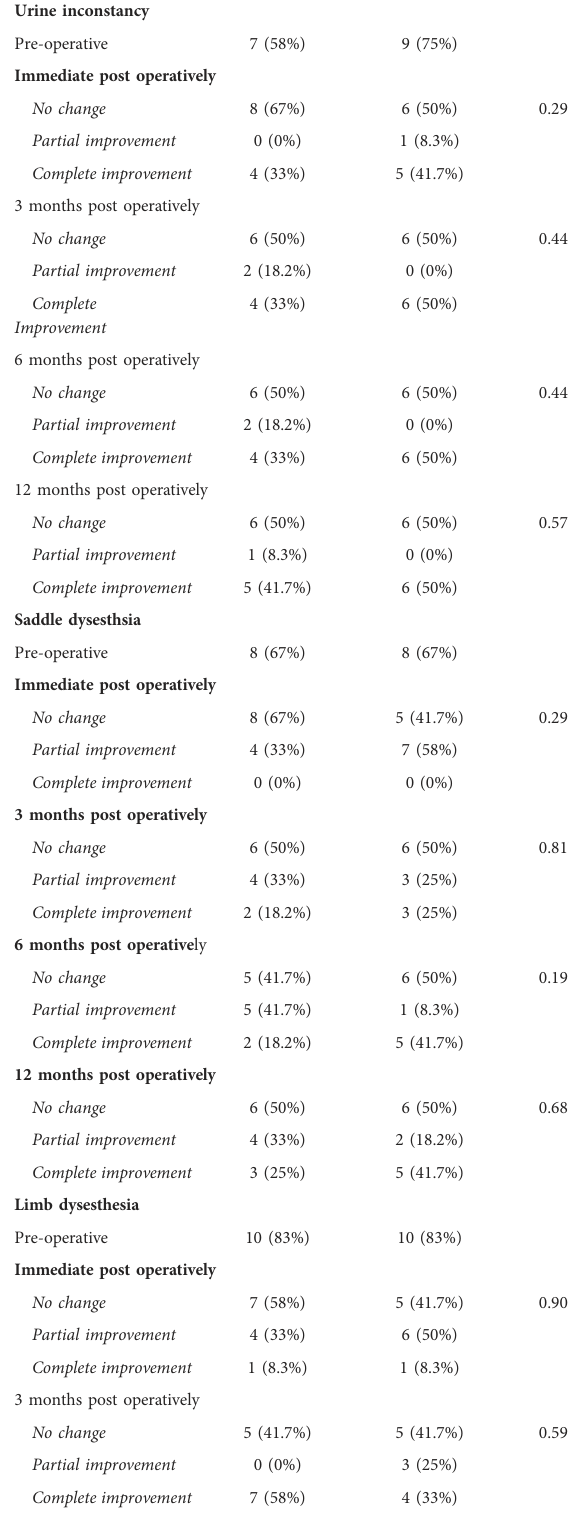
TABLE 4 Patient self-reported neurological